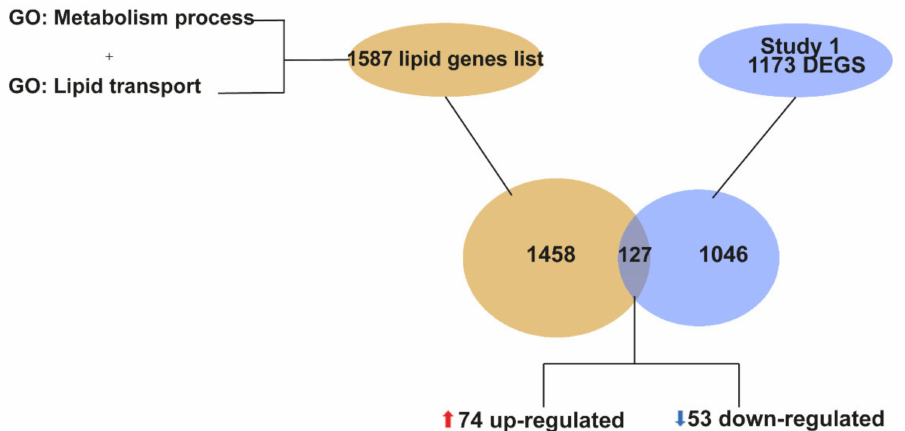
Figure 2. Graphical representation of the identification of genes related to lipid metabolism among the total of DEGs identified at P90. The lipid gene list was obtained by joining genes annotated in the GO terms “lipid metabolism process “(GO:0006629) and “lipid transport” (GO:0006869), resulting in a total of 1587 lipid genes annotated. The Venn diagram is showing that out of the 1173 DEGs identified in our study, a total of 127 DEGs are lipid genes, of which 74 are upregulated and 53 downregulated. 2.3. Meta-Analysis of RNA-seq Datasets from Spinal Cord of SOD1 Mice at Early and